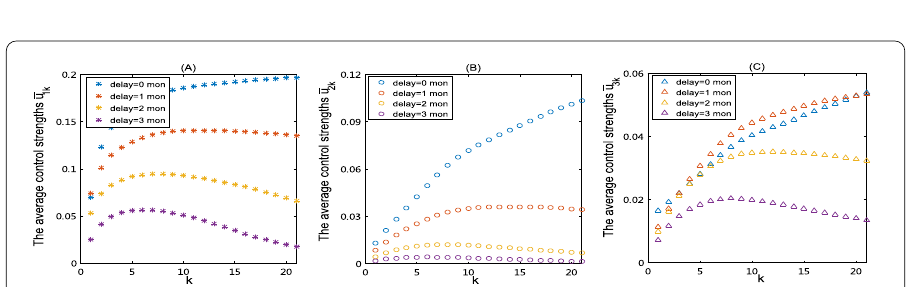
Figure 7 ( A )–( C ) The time series of optimal control function for group 10 (i.e. k = 10) under four different timings of the implementation of control measures (delay time = 0,1,2,3 month); ( D ) the corresponding densities of infected nodes in group